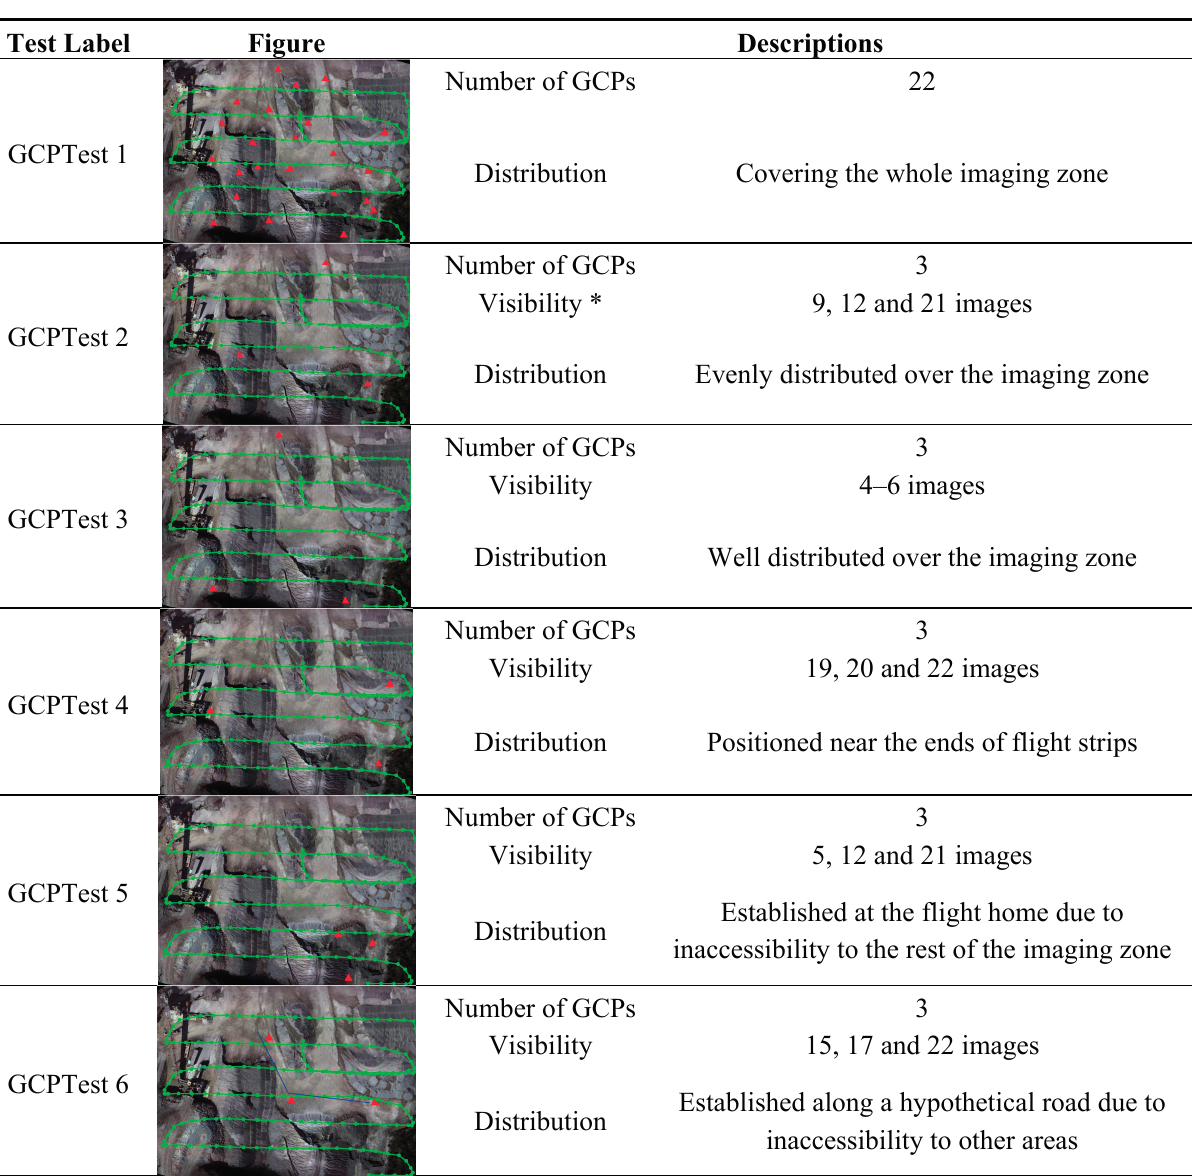
Table 2. Description of experimental tests for verifying the effect of number/distribution of GCPs.